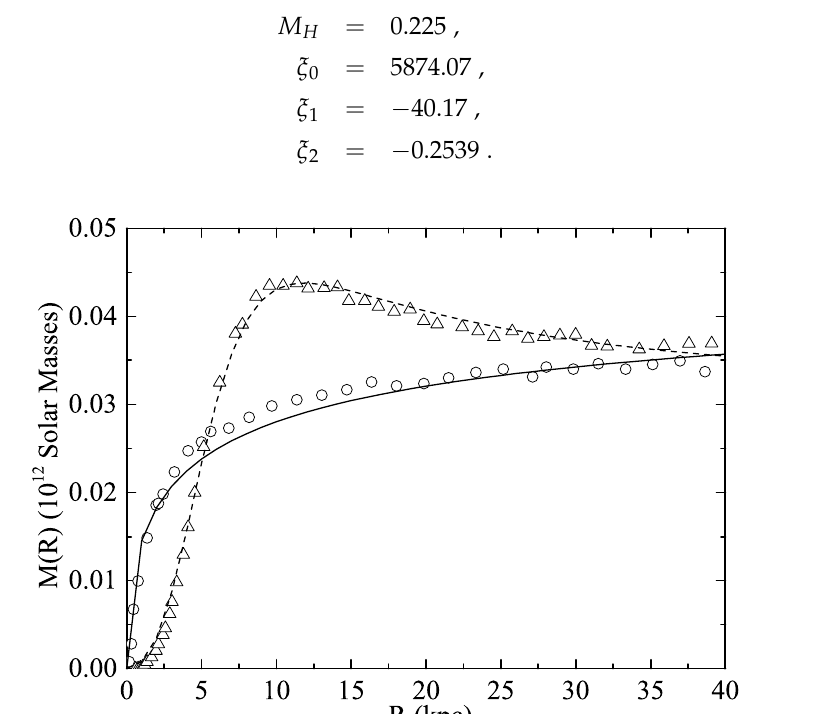
Figure 1. Mass functions for the bulge (open circles) and the disk (triangles) according to the Kalberla–Kerp model. The fittings by the Padé approximants are displayed as a solid and a dashed line,